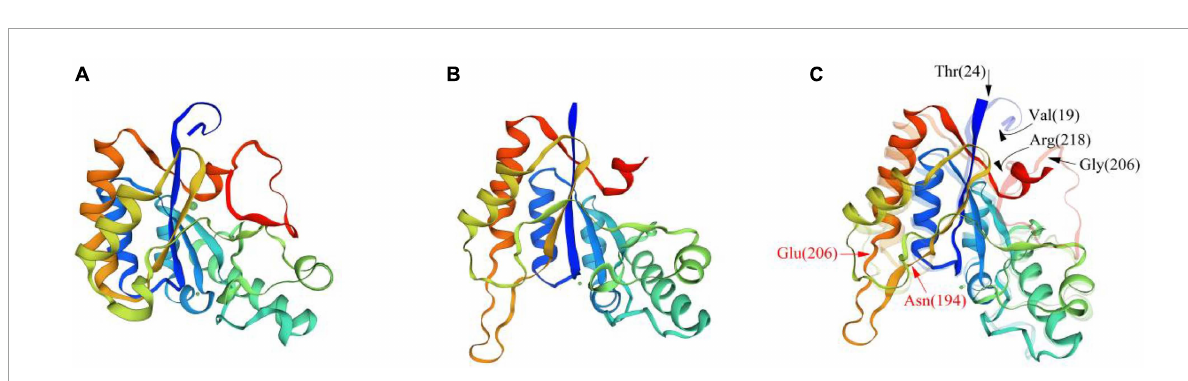
sediments microbes are an important reservoir of novel bioactive substances with considerable potential for